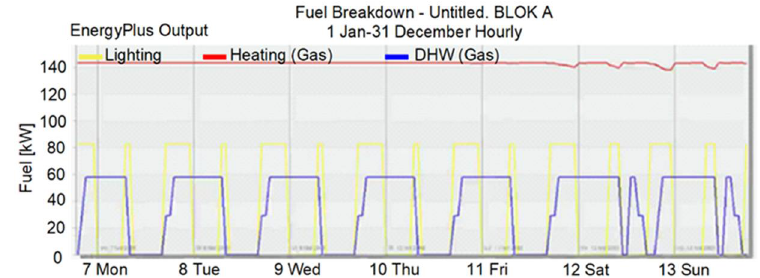
Figure 16. Energy consumption before reconstruction of Block A in winter (weekly section).